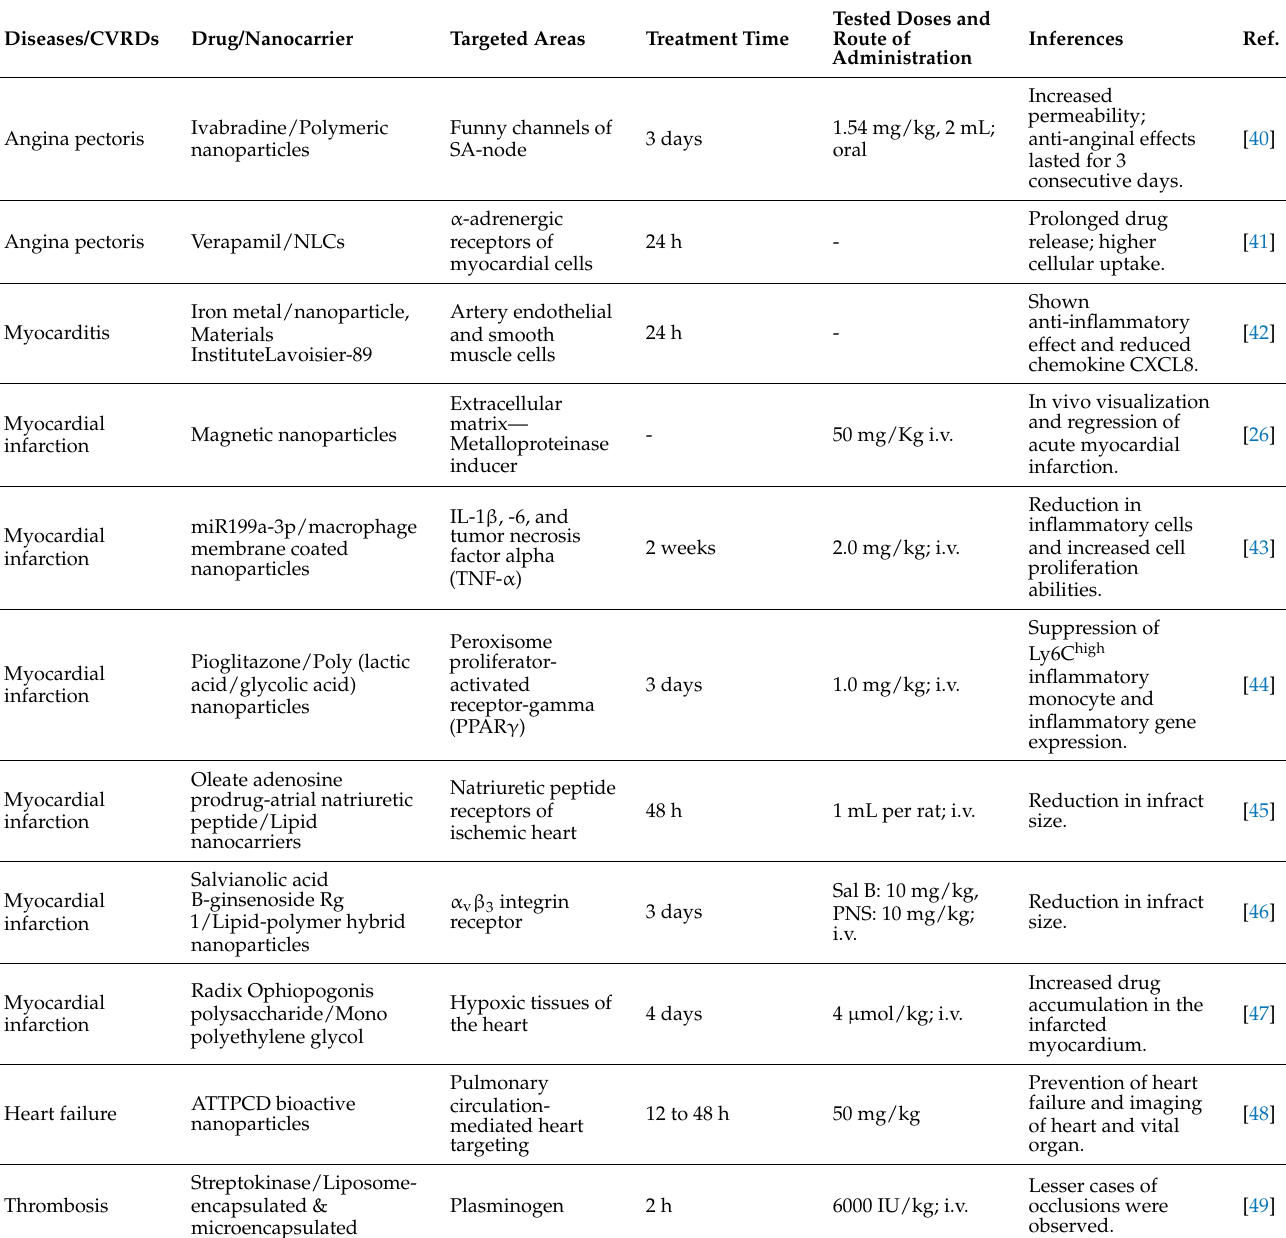
Table 1. Different targeted/theranostic approaches of nanomedicine for